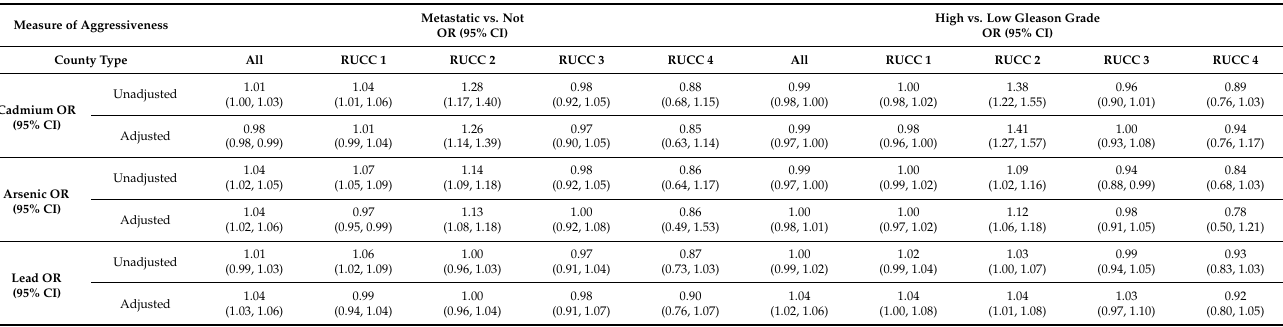
Table 2. Adjusted and unadjusted odds ratios and 95% confidence intervals for aggressive prostate cancer for cases from the 2010–2014 Surveillance, Epidemiology and End Results (SEER) database for cadmium, arsenic, and lead each as the exposure variable comparing the 80th percentile of exposure vs. the 20th percentile in counties with different degrees of urbanization. Metastaticvs. Not Highvs. LowGleasonGrade OR(95%CI)